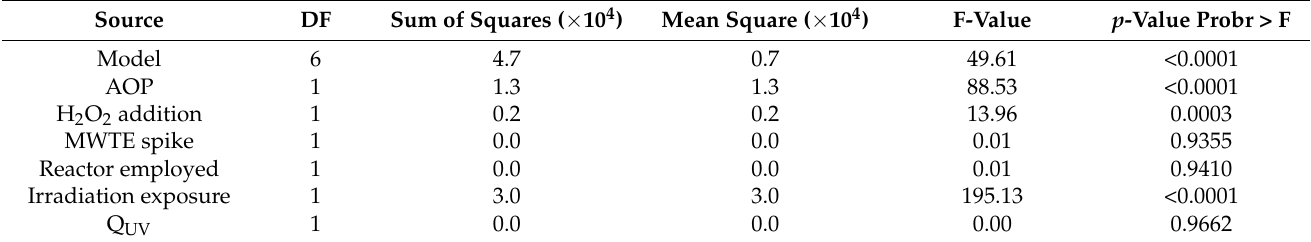
Table 9. Summary of ANOVA for As III